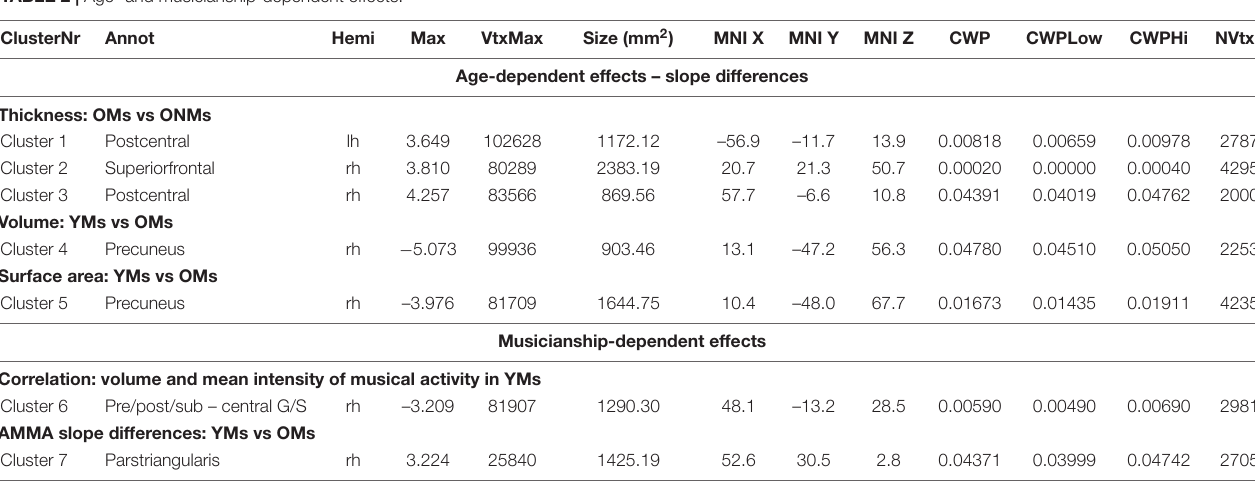
FIGURE 2 | Average structural metrics. Group averaged maps for (A) thickness, (B) volume, and (C) surface area projected on group-averaged inflated pial surfaces. Color scales present smaller values in red and higher values in blue (set up using FreeView). See Supplementary Table 3 for more details. YMs, young musicians; OMs, old musicians; ONMs, old non-musicians; THK, thickness; VOL, volume; SA, surface area; LH/RH, left hemisphere/right hemisphere. TABLE 2 | Age- and musicianship-dependent